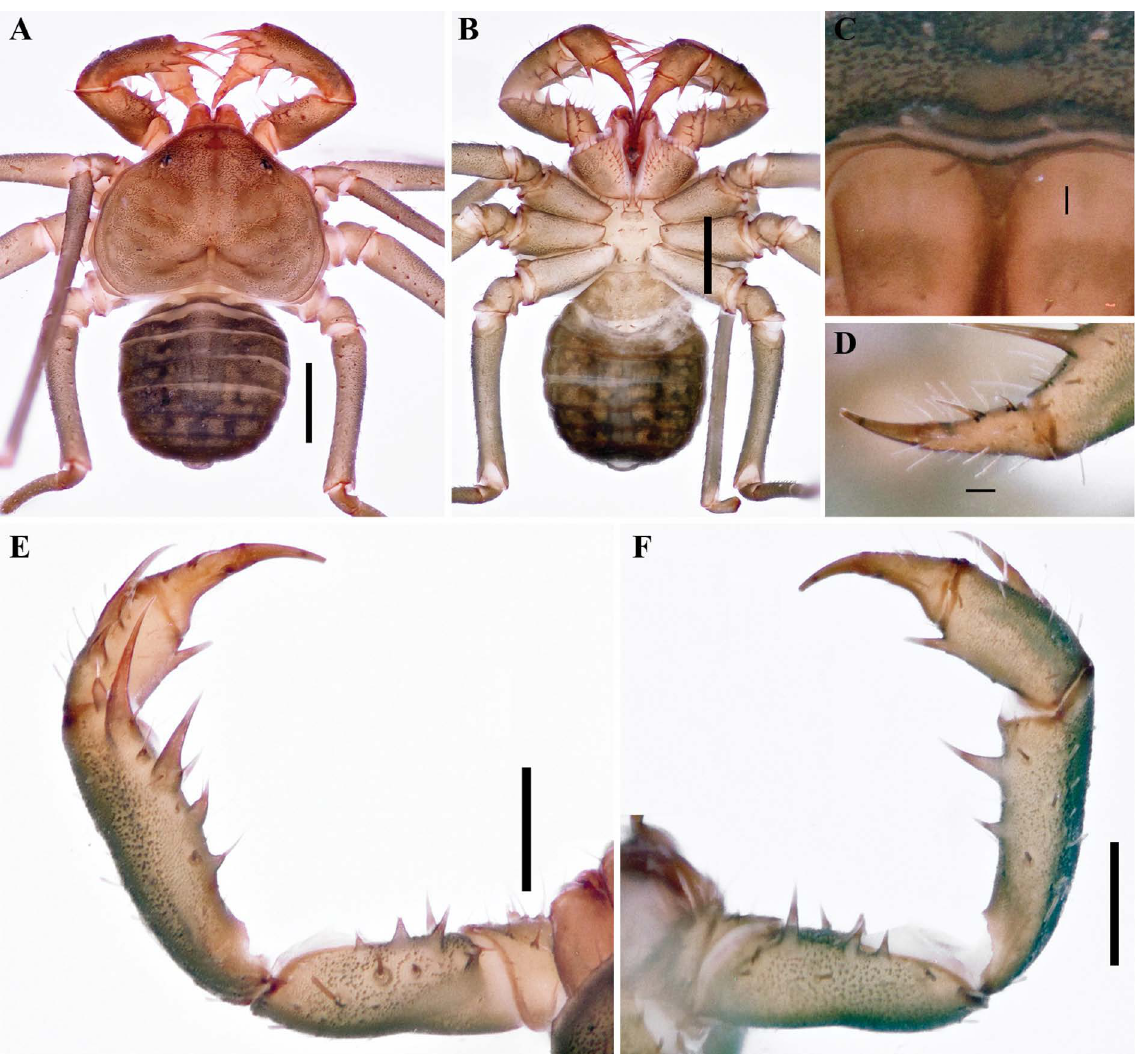
Fig. 28. Charinus carvalhoi sp. nov. (CHNUFPI 1324), general morphology, ♀. A . Habitus, dorsal view. B . Habitus, ventral view. C . Frontal process. D . Pedipalp tarsus, frontal view. E . Pedipalp, dorsal view. F . Pedipalp, ventral view. Scale bars: A–B = 1 mm; C–D = 0.1 mm; E–F = 0.5